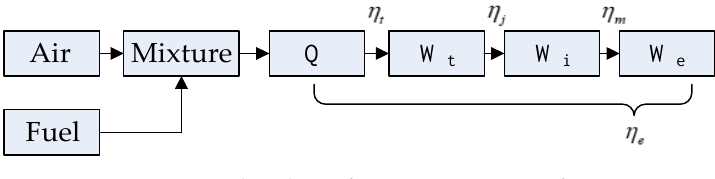
Figure 2. Flowchart of Engine energy transfer.